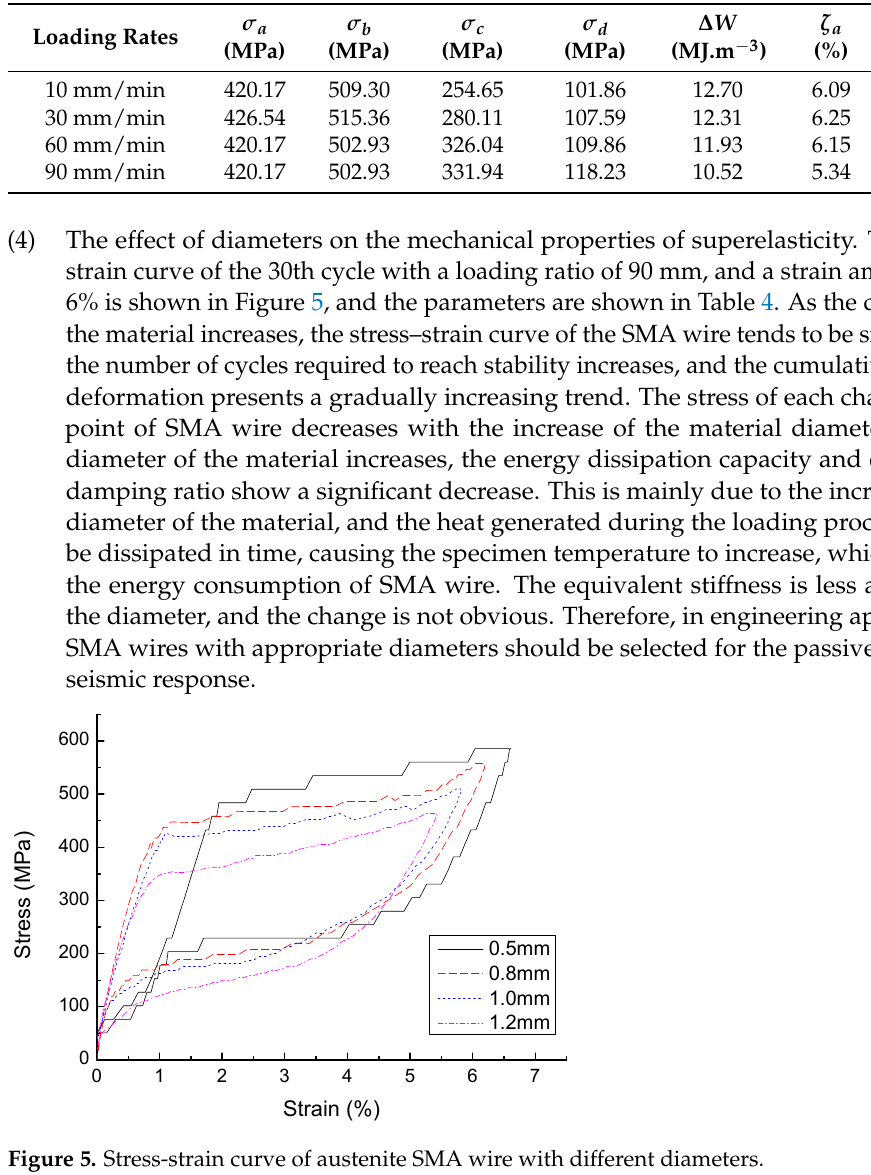
Table 3. Mechanical properties of SMA wires with different loading rates.